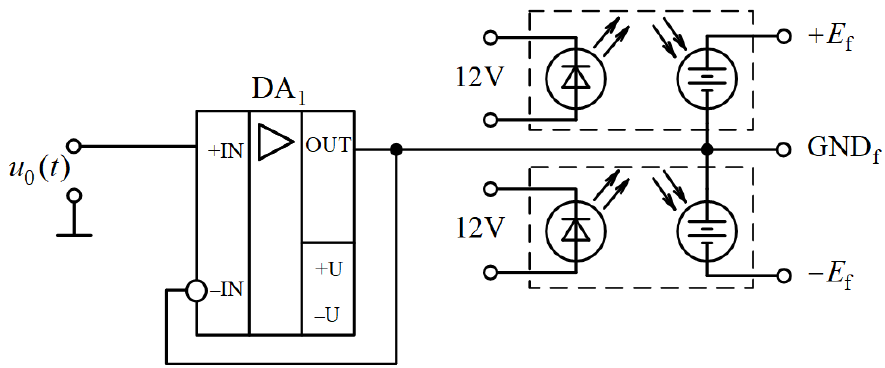
Figure 3. Voltage follower output stage with embedded photovoltaic modules.